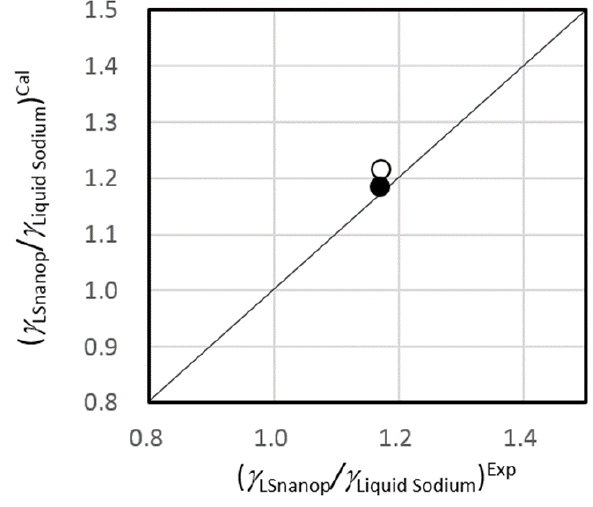
Figure 7. Comparison of the surface tension ratio ( γ LSnanop/ γ liquid Na ) between the calculation by Equation (4) (indicated by “Cal”) and the experiment (indicated by “Exp”) at the melting temperature of Na; solid circle: the calculation without atomic volume correction; open circle: the calculation with atomic volume correction. The slanted line corresponds to the case on which the calculated values are same as experimental